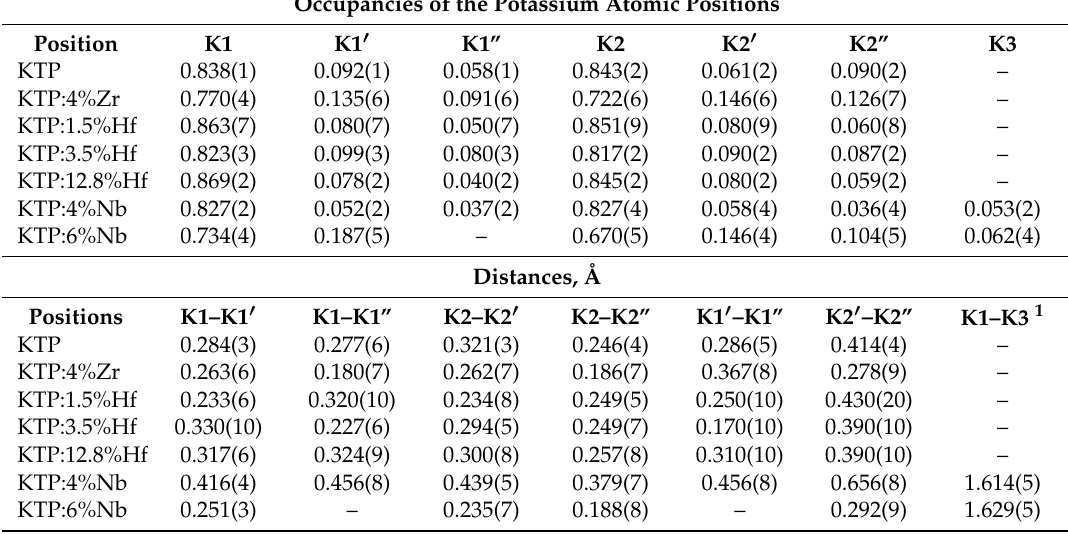
Table 6. Occupancies of potassium atomic positions and distances between these positions in the structure of pure KTP [46], KTP:4%Zr [36], KTP:1.5%Hf, KTP:3.5%Hf, KTP:12.8%Hf [37], KTP:4%Nb, and KTP:6%Nb [38].